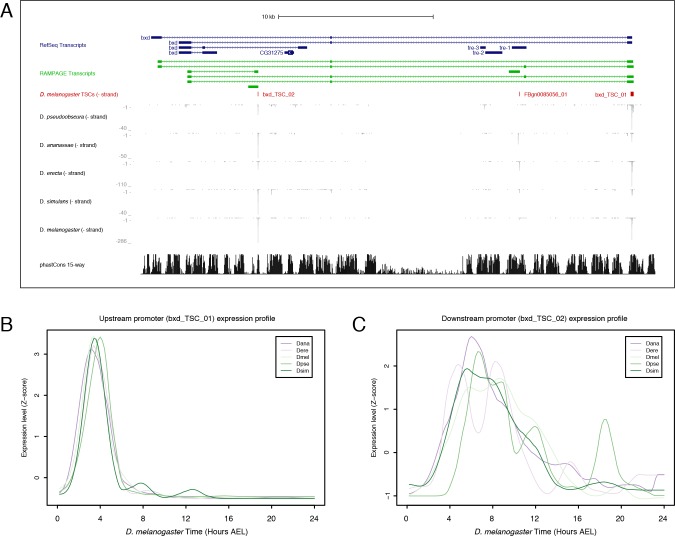
Bithoraxoid locus.(A) Organization of the bithoraxoid locus (Figure generated with the UCSC Genome Browser). (B) Expression profiles of the upstream bxd promoter in the five species studied. (C) Expression of the downstream promoter.